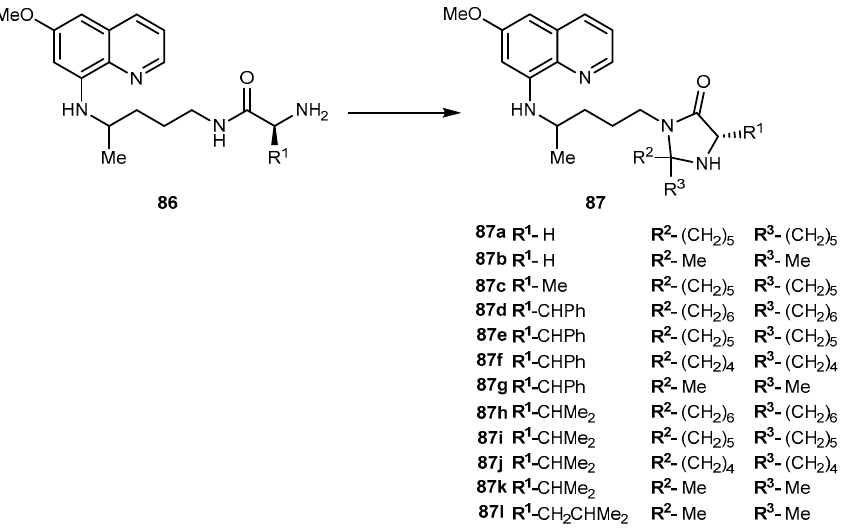
Figure 36. Formation of imidazolidin-4-ones derivatives of 4 (Adapted from [135]).